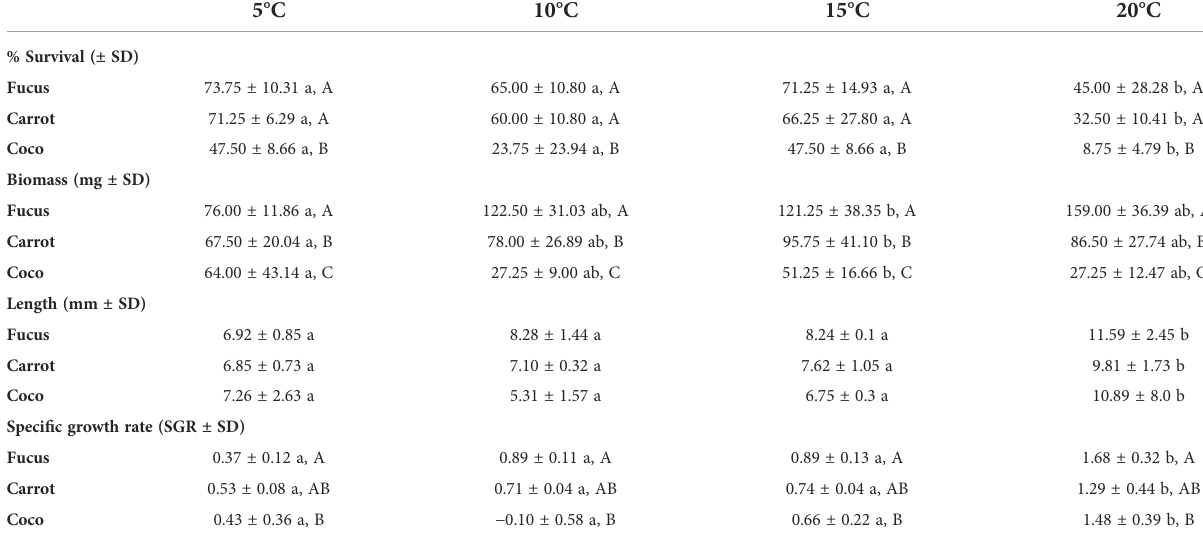
TABLE 1 Survival, total biomass, and total length of G. locusta in response to different diets and temperatures after the 21-day feeding